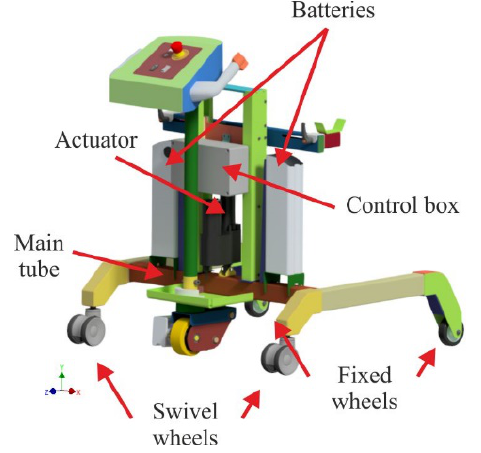
Figure 7. Main components of the designed equipment.